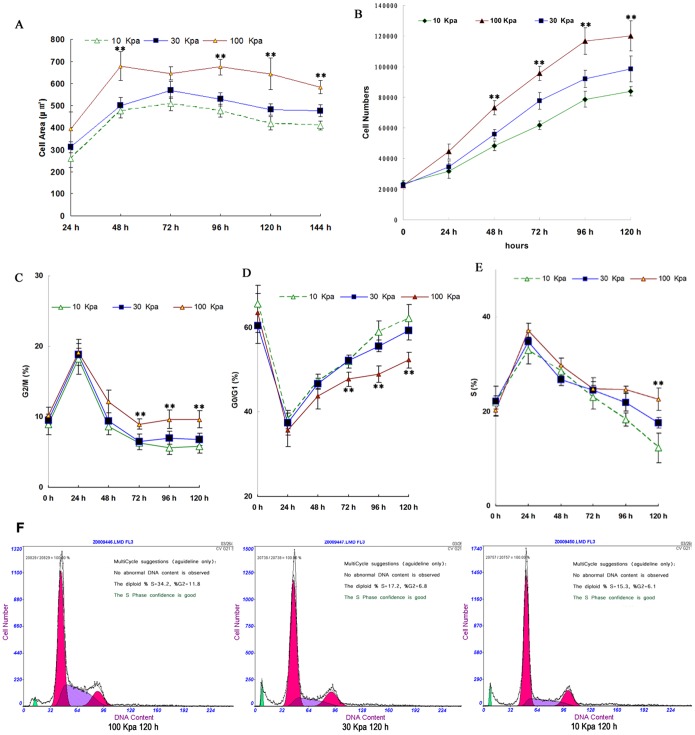
Effects of substrate rigidity on cell proliferation, spreading area, and cell cycle in the MCF-7 breast cancer cells.(A) The cellular spreading area of MCF-7 cells grown on different rigidity substrates for different lengths of times. Data are presented as the means ± SEM from three independent experiments. **P<0.01. (B) The proliferation rate of MCF-7 cells grown on different rigidity substrates for different lengths of time. Data are presented as the means ± SEM from three independent experiments. **P<0.01. (C–E) Cell cycle analysis of MCF-7 cells grown on different rigidity substrates in three independent experiments. **P<0.01. (F) MCF-7 cells grown on different rigidity substrates for 120 hours; data show the results of flow cytometry plots from one of three independent experiments.